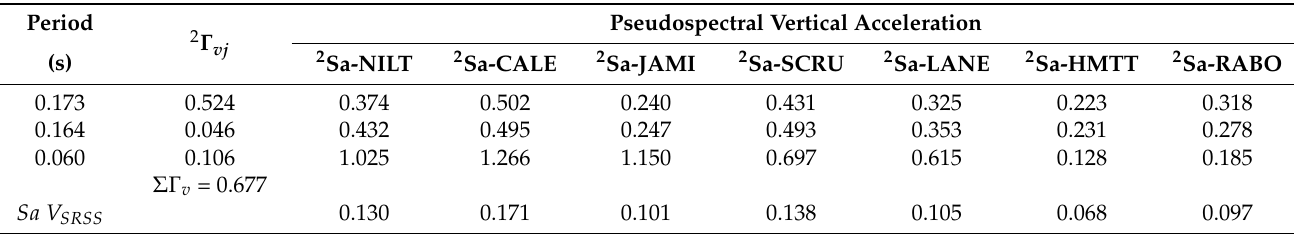
Table 5. Accelerations due to horizontal earthquake in the 6-story building.